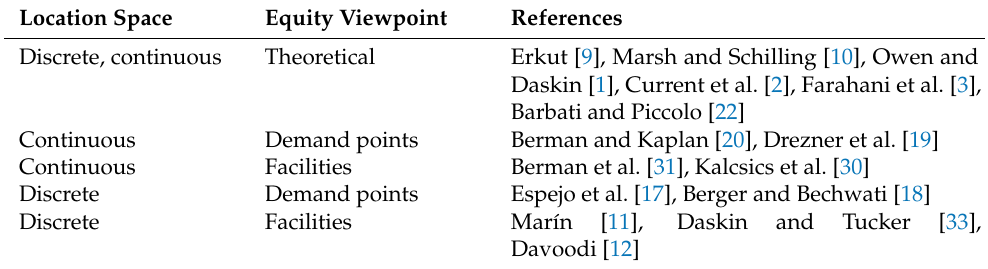
Table 1. Classification of the